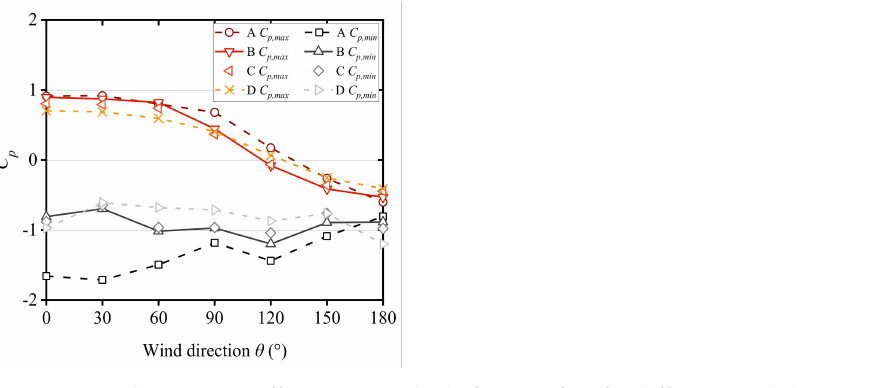
Figure 7. Wind pressure coefficients on each platform surface for different wind